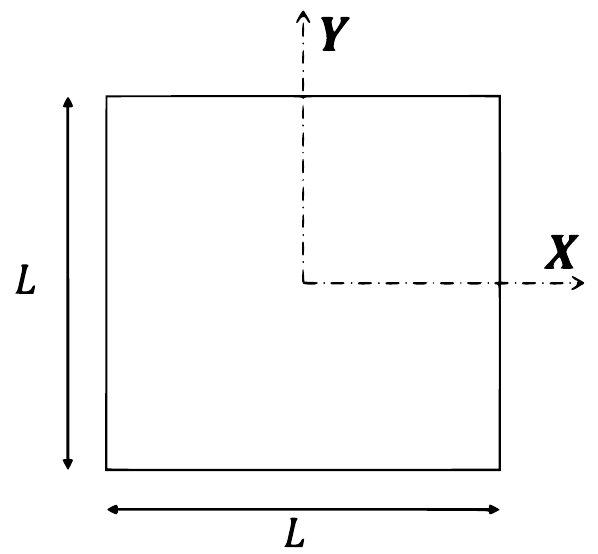
Figure 14. Evolution of an initially-square fluid patch: initial